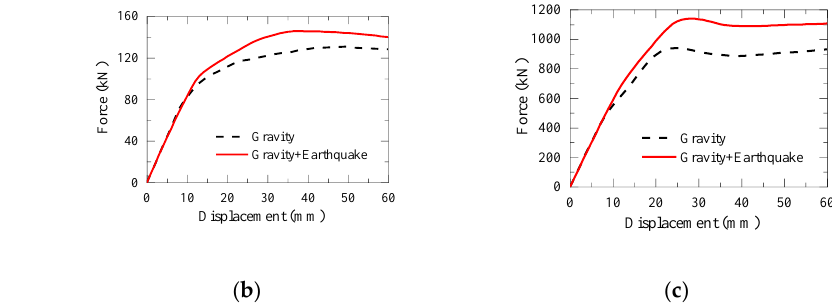
Figure 7. Force-displacement curves of columns under different compression loads: ( a ) Original station; ( b ) Original tunnel; ( c ) New